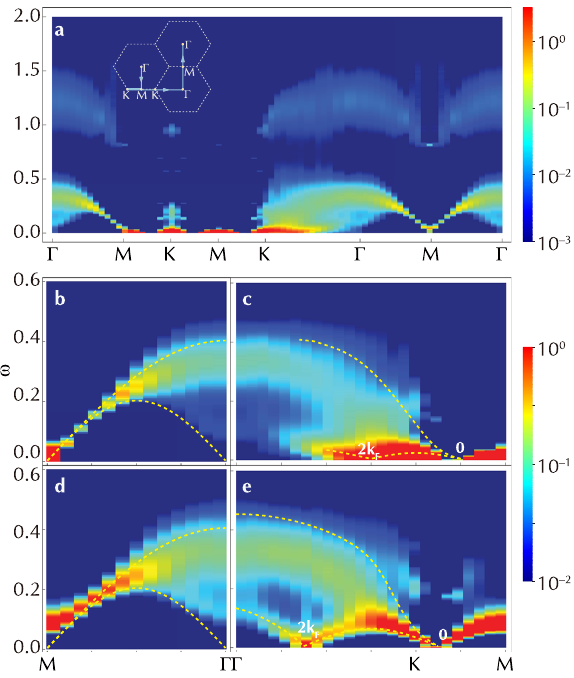
Fig. 3 The spectra at low string density. a The spectra at string density ρ s = 1/3 measured at λ = 0.895, Δ = 0.2, system size L = 24 and temperature T = 1/96 in the unit of J . The path taken in the Brillouin zone is speci fi ed in the inset. b , c The zoom-in of low energy region are dived into parallel to the strings ( b ) along Γ M line and perpendicular to the strings ( c ) along Γ KM line respectively. d , e The low energy excitation spectra measured at λ = 0.91 and = 1/2 includes parallel to the strings ( d ) along Γ M line and ρ s perpendicular to the strings ( e ) along Γ KM line respectively. The dashed lines denote the anticipated results in spin-1/2 XY chain ( b , d ) and Luttinger liquid ( c , e ). The gray italic momentum labels ‘ 0 ’ and ‘ 2 k F ’ are the momenta measured from the Fermi point of the projected 1d